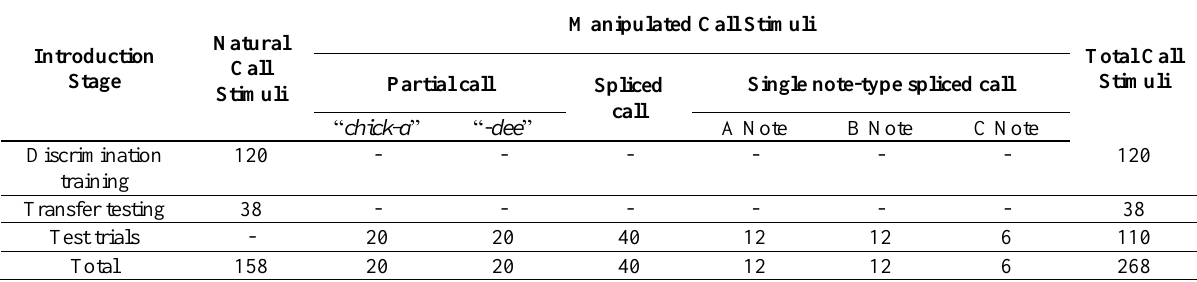
Summary of the 268 Acoustic Stimuli Presented in Experiment 1 and Modified for Experiment 2, Including Stimulus Type and